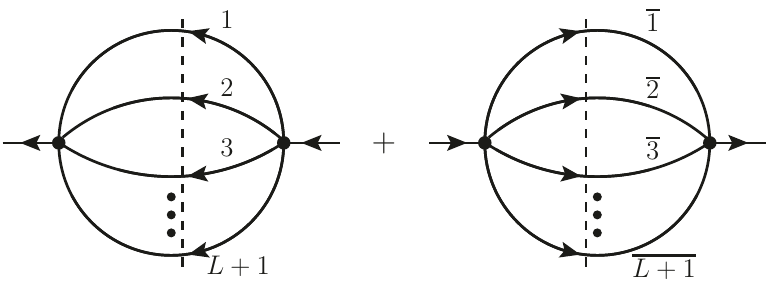
Figure 3 . Causal thresholds of the MLT topology. The arrow on the external momentum represents the positive energy